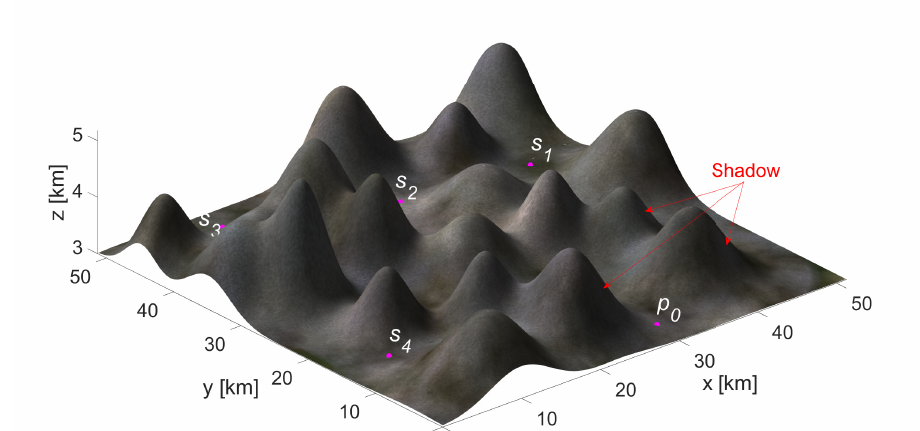
Figure 9. The simulated mountain region with a UAV depot and four sites.